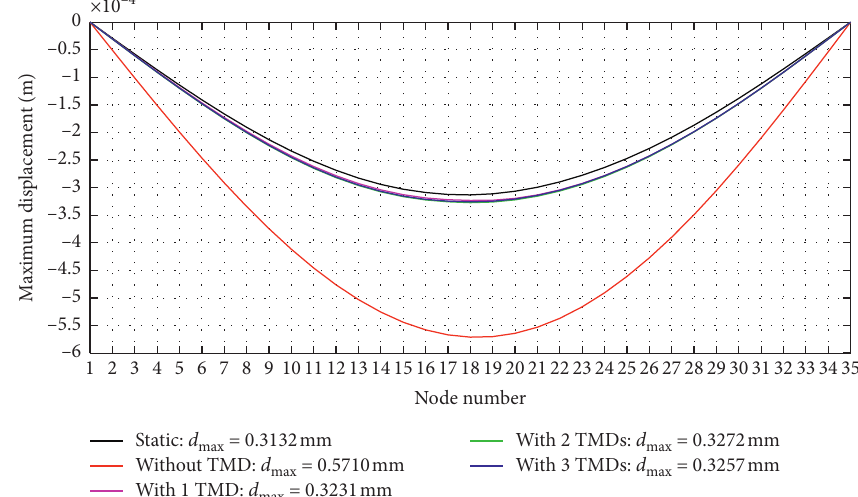
Figure 8: Maximum vertical displacement for each node of the bridge, for static case (black curve), dynamic without TMD (red curve), with 1 TMD (magenta curve), with 2 TMDs (green curve), and with 3 TMDs (blue curve).